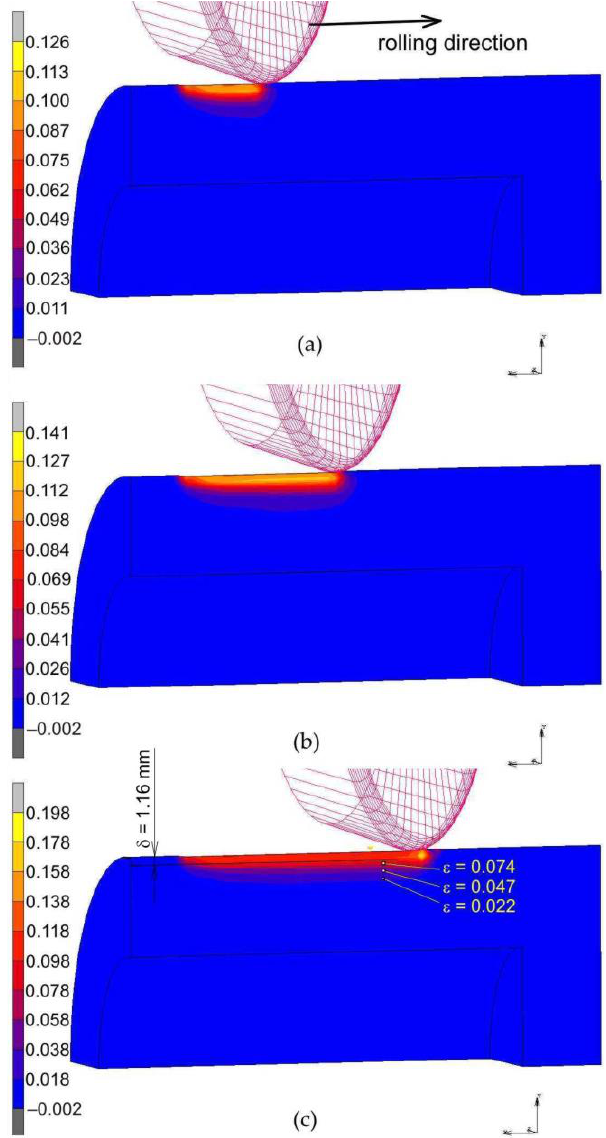
Figure 16. Distribution of equivalent plastic strain ε after roller burnishing with braking moment across the width of the rings packet: ( a ) 10 mm, ( b ) 20 mm and ( c ) 30